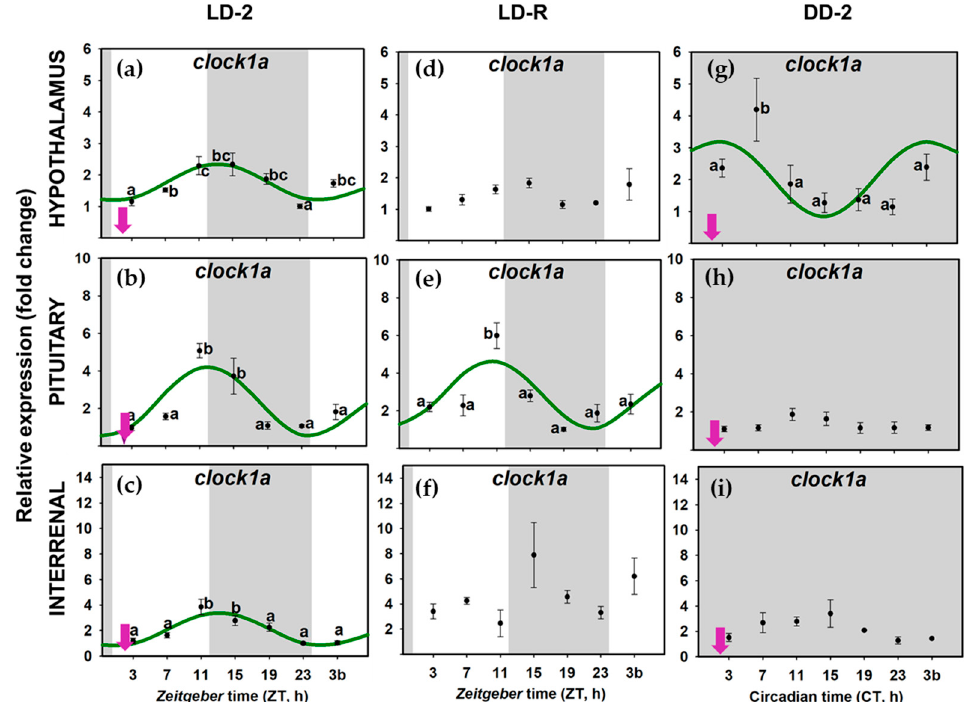
Figure 6. Relative expression of clock1a in hypothalamus ( a , d , g ), pituitary ( b , e , h ) and interrenal tissue ( c , f , i ) of goldfish. Data are expressed as mean ± standard error ( n = 8). Grey areas indicate the darkness period, and arrows point to the feeding time when it was fixed. Different letters show significant differences among groups (ANOVA and SNK test). The curves show sinusoidal periodic functions obtained by cosinor analysis when it was significant (noise/signal <